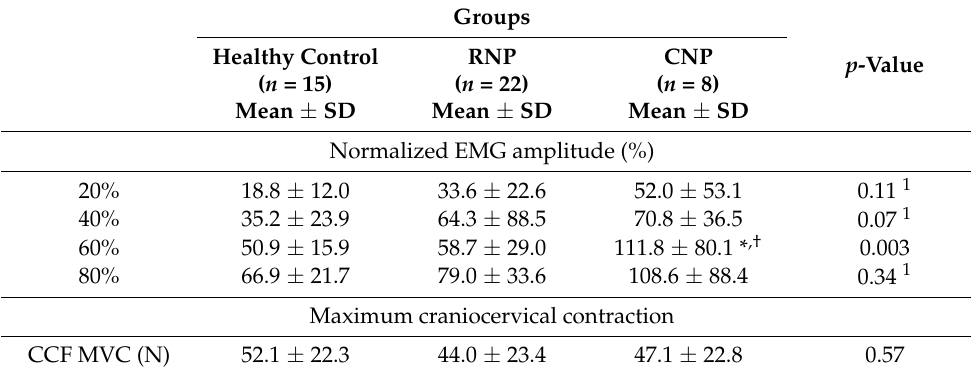
Table 4. Normalized EMG amplitude (%) recorded from sternocleidomastoid muscles during each of the five submaximal craniocervical flexion contractions in addition to the maximum craniocervical contraction.